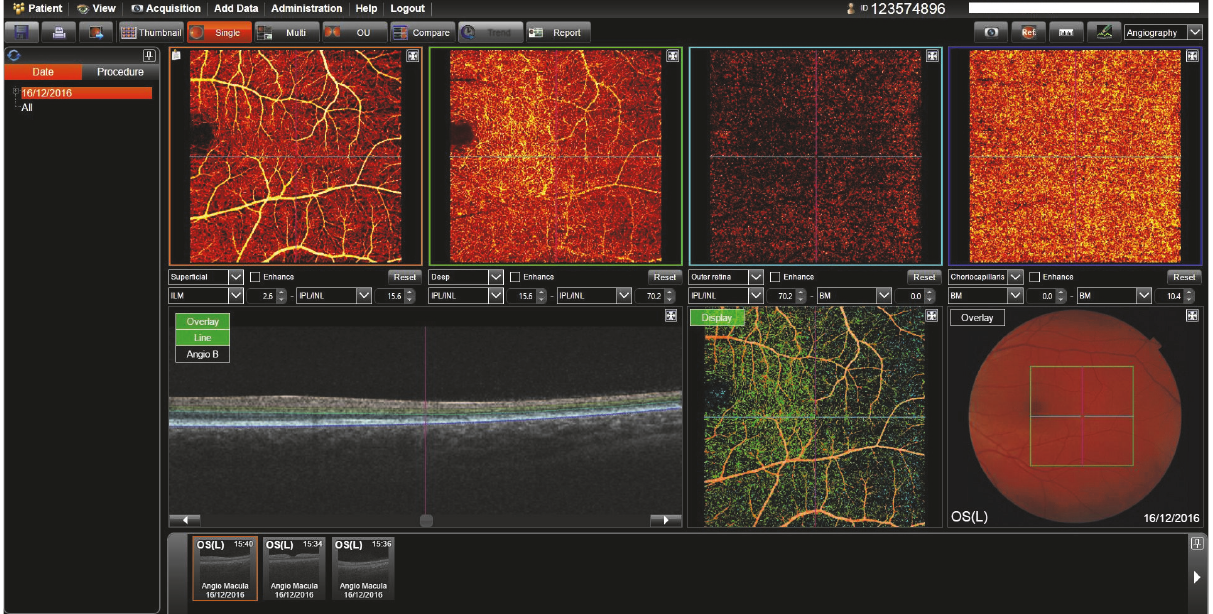
Figure 8: Optical coherence tomography angiography (OCTA) shows a rarefication of the deep retinal capillaries. Superficial retinal capillaries and choroidal circulation do not seem to be